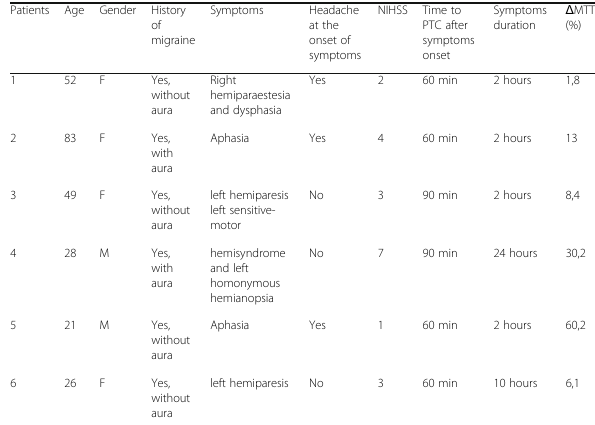
Table 1 (abstract P177). Clinical features of the six patients with migrainous aura Patients Age Gender History